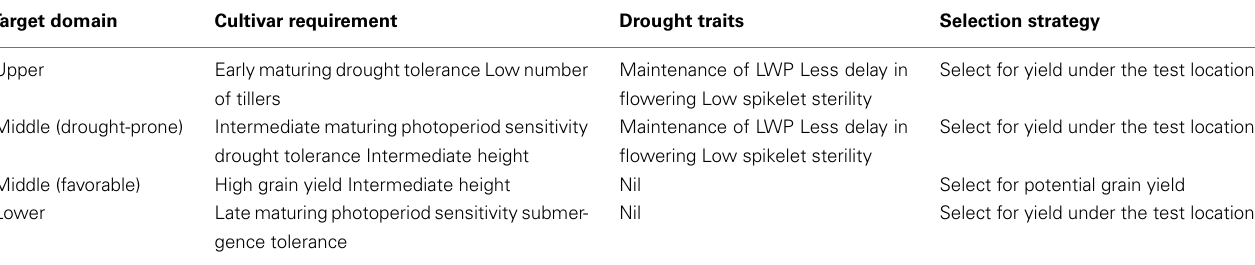
TableA2 | Selection criteria to develop varieties for each target